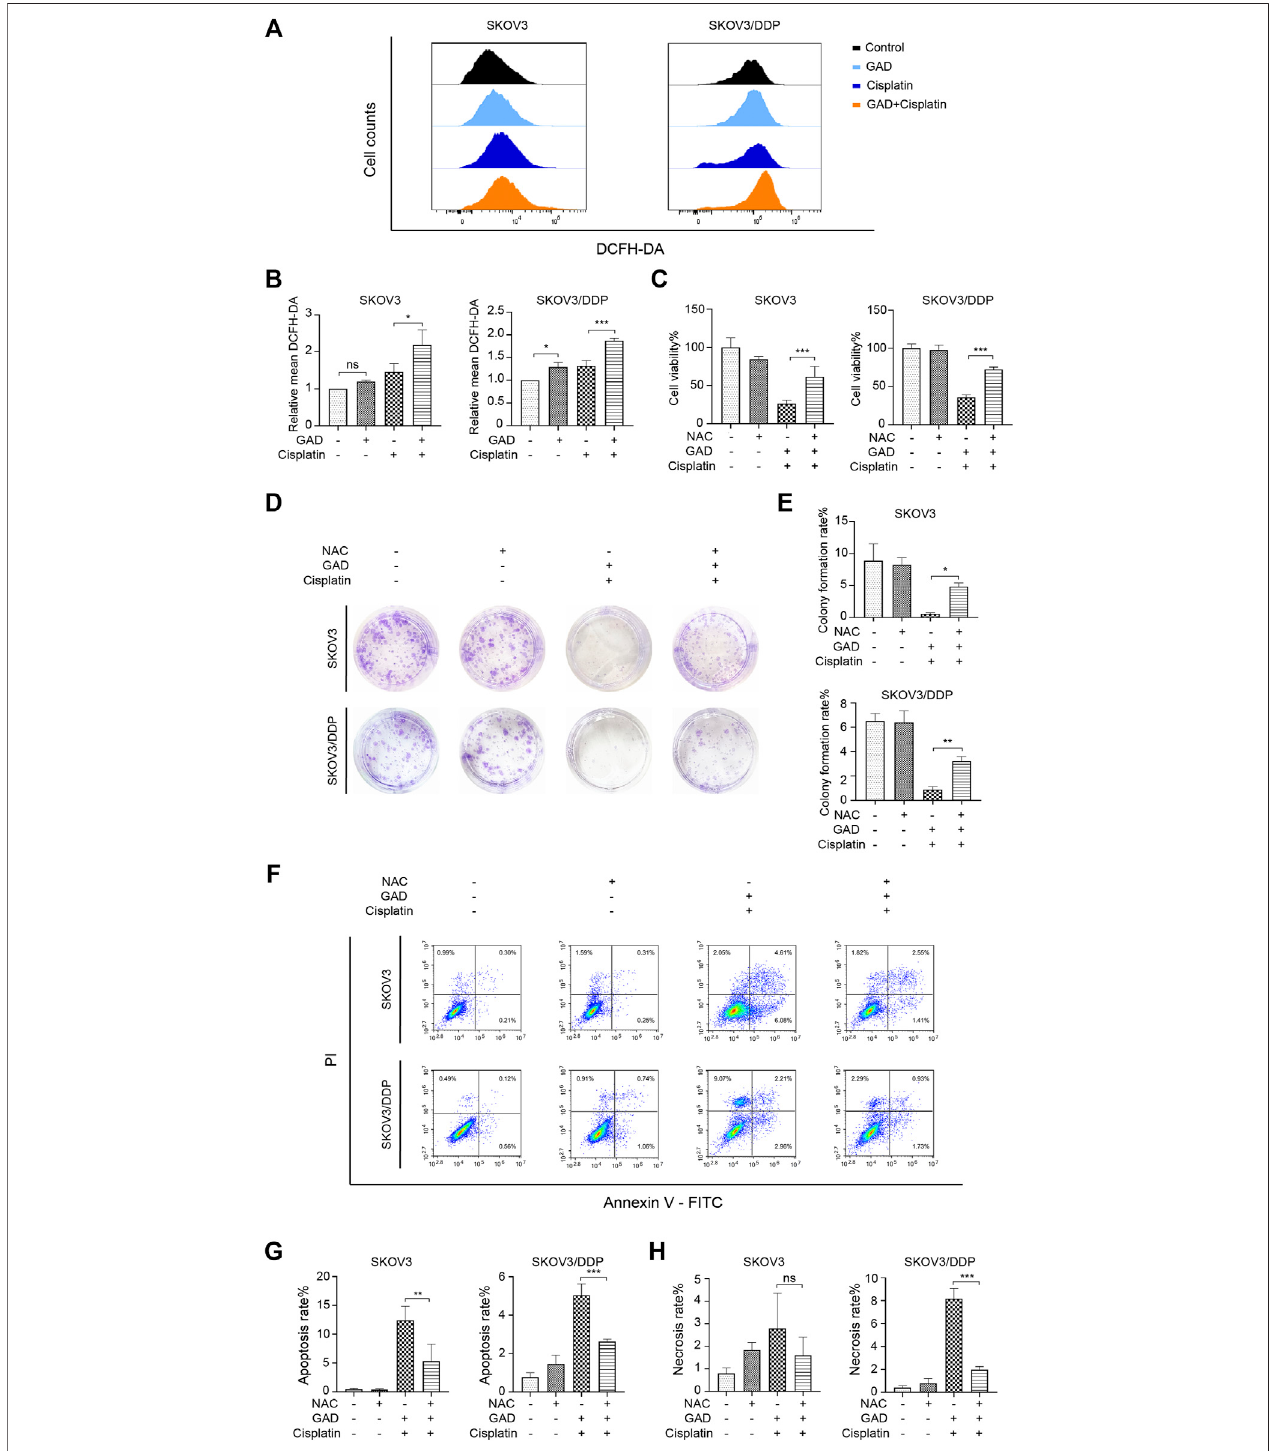
FIGURE 4 | The combination of GAD and cisplatin induced ROS-mediated growth inhibition and cell death in SKOV3 and SKOV3/DDP cell lines. (A) SKOV3 and SKOV3/DDP were treated with GAD (200 μ M) and cisplatin (40 μ M for SKOV3 and 200 μ M for SKOV3/DDP) alone and their combination for 24 h and the intracellular ROSwasmeasured byDCFH-DA probe. (B) Thequantitativeanalysisofmeanin fl orescenceintensityofDCFH-DA inSKOV3and SKOV3/DDP. (C) Supplementingwith 10 mM NAC for 24 h partially reversed the cell viability inhibition in SKOV3 and SKOV3/DDP. (D,E) The images of colony formation and the corresponding quantitativeanalysis. (F) TheapoptosisandnecrosisofSKOV3andSKOV3/DDPtreatedwiththecombinationofGADandcisplatinwithorwithout10 mMNACfor24 h. (G,H) Thequantitativeanalysisofapoptosis rateandnecrosisrateofSKOV3and SKOV3/DDP.NAC:N-acetyl-L-cysteine.Dataarepresentedasthemean±SD( n =3). *** p < 0.001, ** p < 0.01; ns, no statistical signi fi cance.